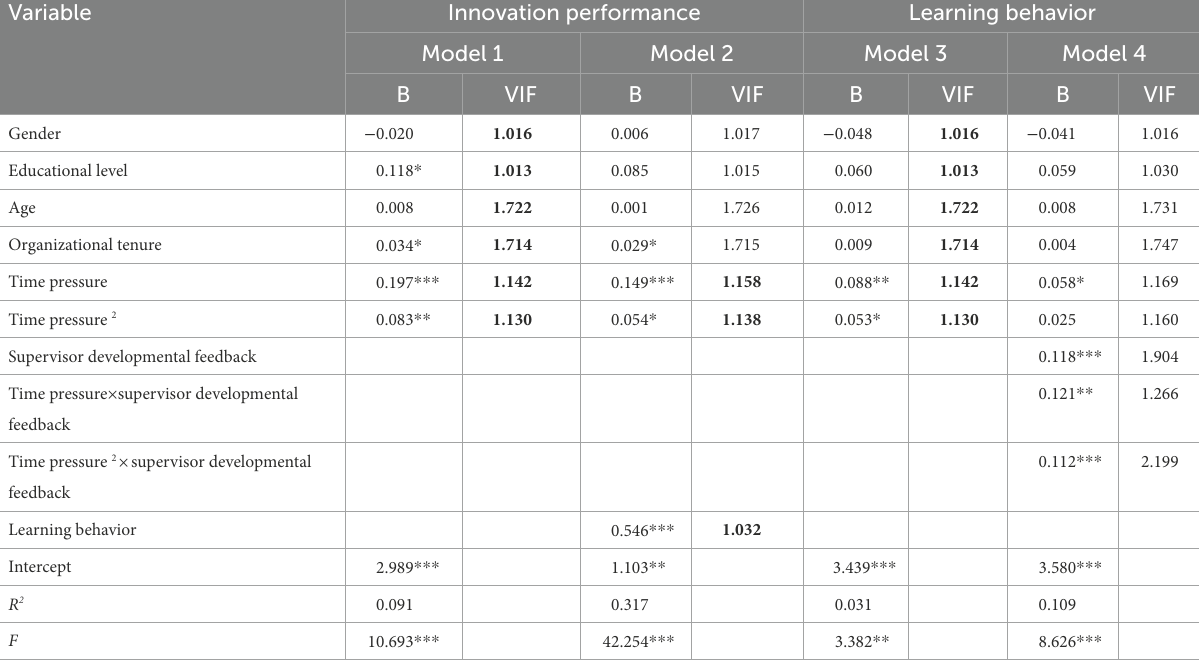
TABLE 6 Analyses predicting learning behavior and innovation performance in Study 2.